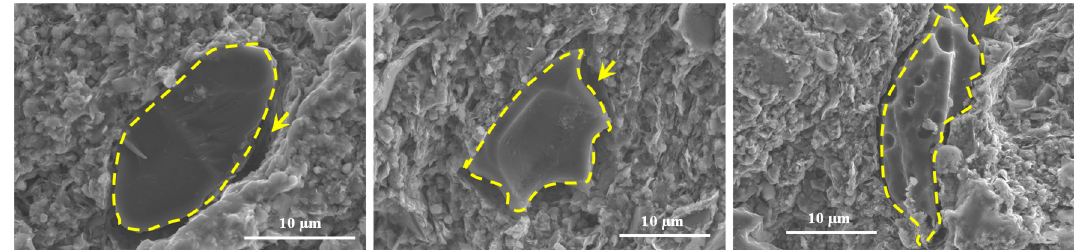
Figure 5. Voids initially filled with OM. SEM images of the samples after the experiment ( A ) sample 12, ( B ) sample #16.